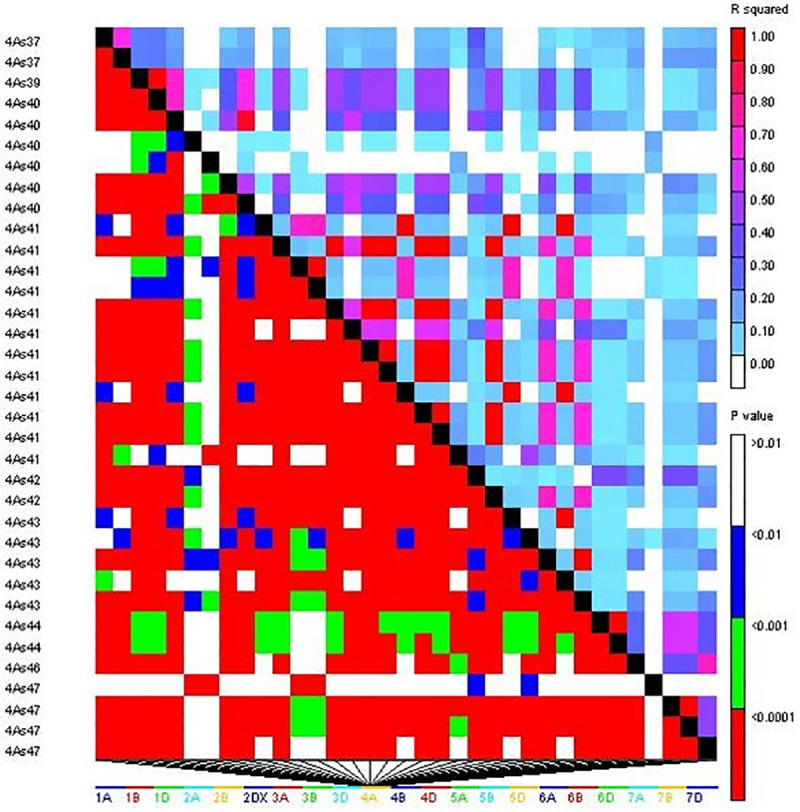
STRUCTURE analysis used to define genetic relationships among 289 wheat lines.The existence of six subpopulations was inferred. Plot was generated using the mean of the variation posterior distribution over inferred admixture proportions. The X-axis shows the membership coefficients and Y-axis shows the different genotype entries. A visual vertical separation represents different subpopulations.